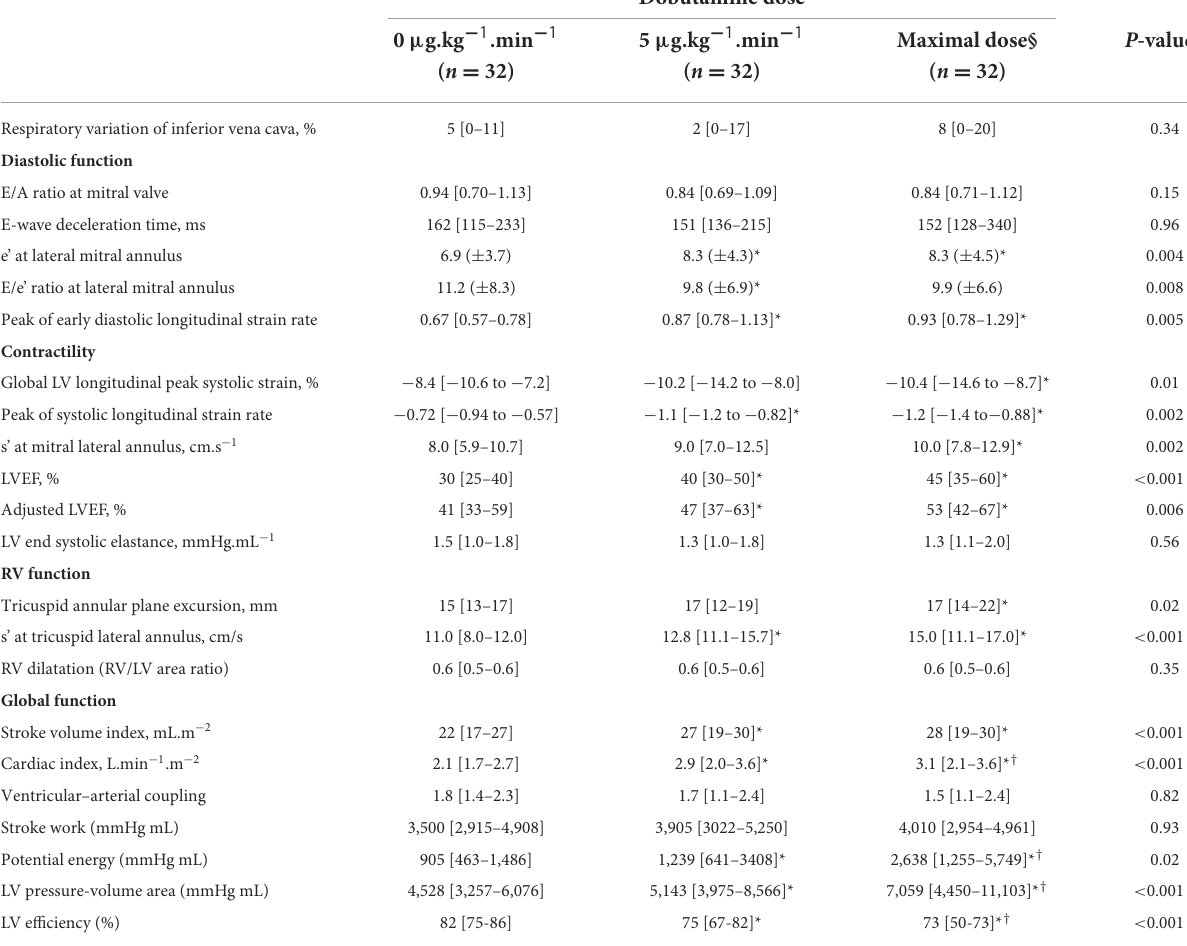
TABLE 3 Echocardiography parameters during dobutamine titration in patients with shock and septic myocardial